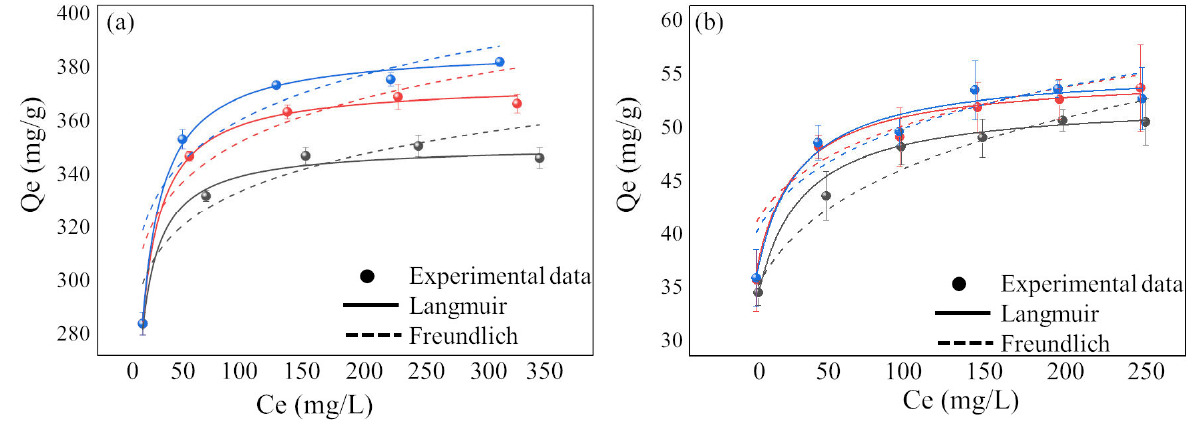
Figure 7. Isothermal adsorption fitting curve of Pb(II) ( a ) and Cu(II) ( b ) at different temperatures (Blue 35 °C, red 25 °C, gray 15 °C).